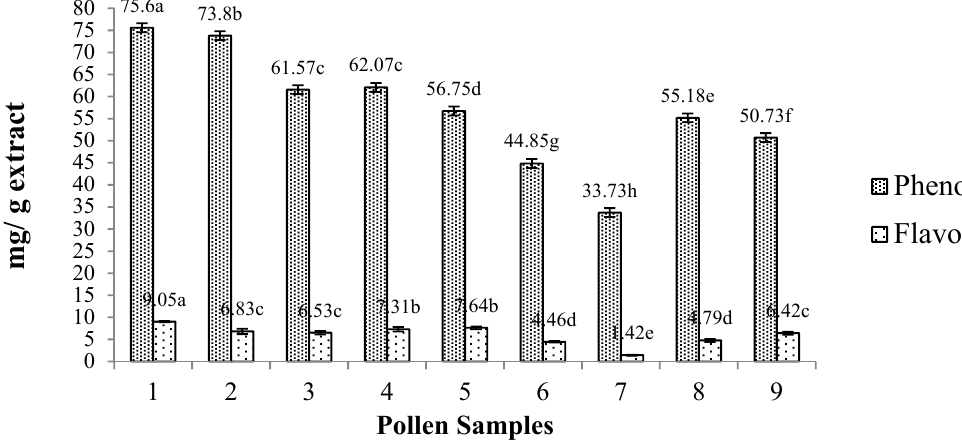
Figure 2. Concentration of total phenolics and flavonoids of the bee pollen extracts (mean ± SD). Different letters represent significant differences ( p < 0.05). Phenols are expressed as mg gallic acid equivalents/g extract (GAE/g extract); while flavonoids are expressed as mg quercetin equivalents/g extract (QE/g extract). Extracts: S1— Cocos nucifera ; S2— Cocos nucifera ; S3— Miconia spp.; S4— Miconia spp.; S5— Miconia spp; S6— Spondias spp.; S7— Myrcia spp.; S8— Eucalyptus spp.; S9— Eucalyptus spp.